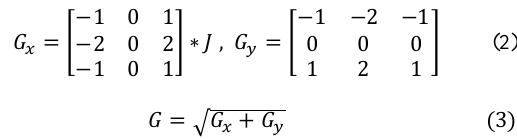
Figure4. The concept of distance estimation